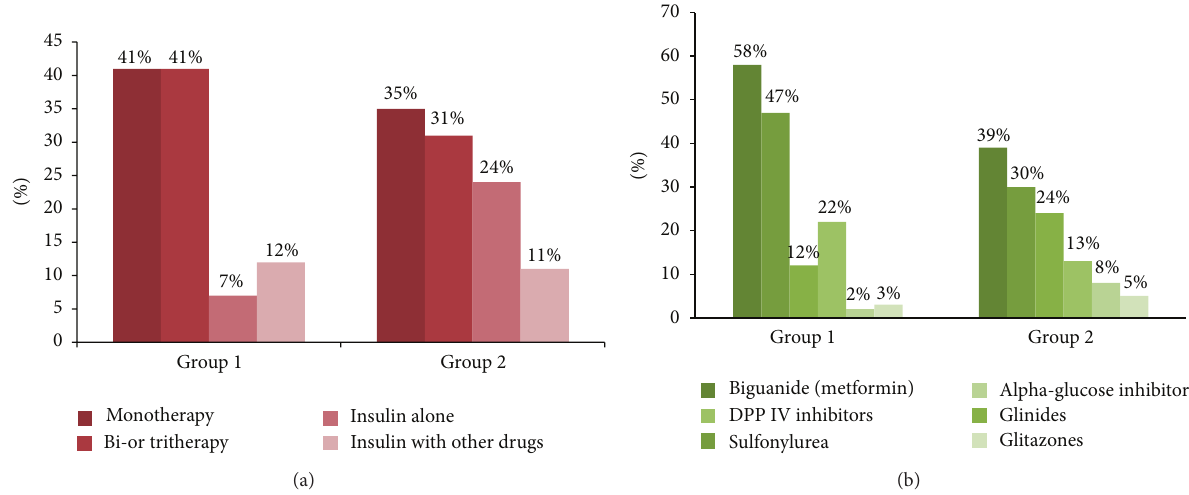
Figure 1: Glucose lowering therapy strategies adopted in the 195 patients with available prescription data. A large proportion of patients were treated with oral mono, dual, or triple therapies while the percentage of patients treated with insulin alone or in association with other drugs was lower and was higher in patients with severe CKD compared to moderate ones.